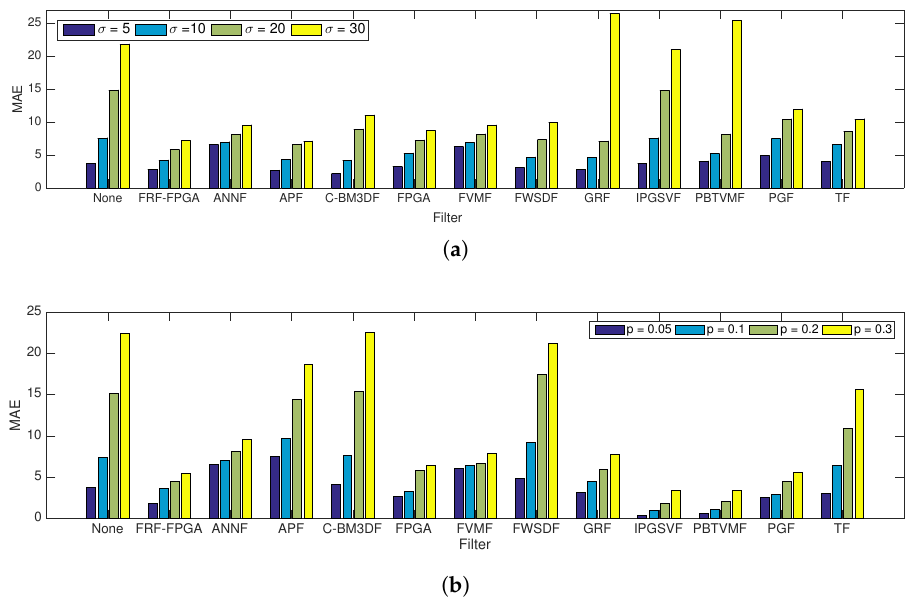
Figure 8. Comparison of mean absolute error (MAE) obtained by state-of-the-art methods when restoring Lena contaminated only with Gaussian noise σ or impulse noise p . ( a ) Lena contaminated only with Gaussian σ . ( b ) Lena contaminated only with impulse p